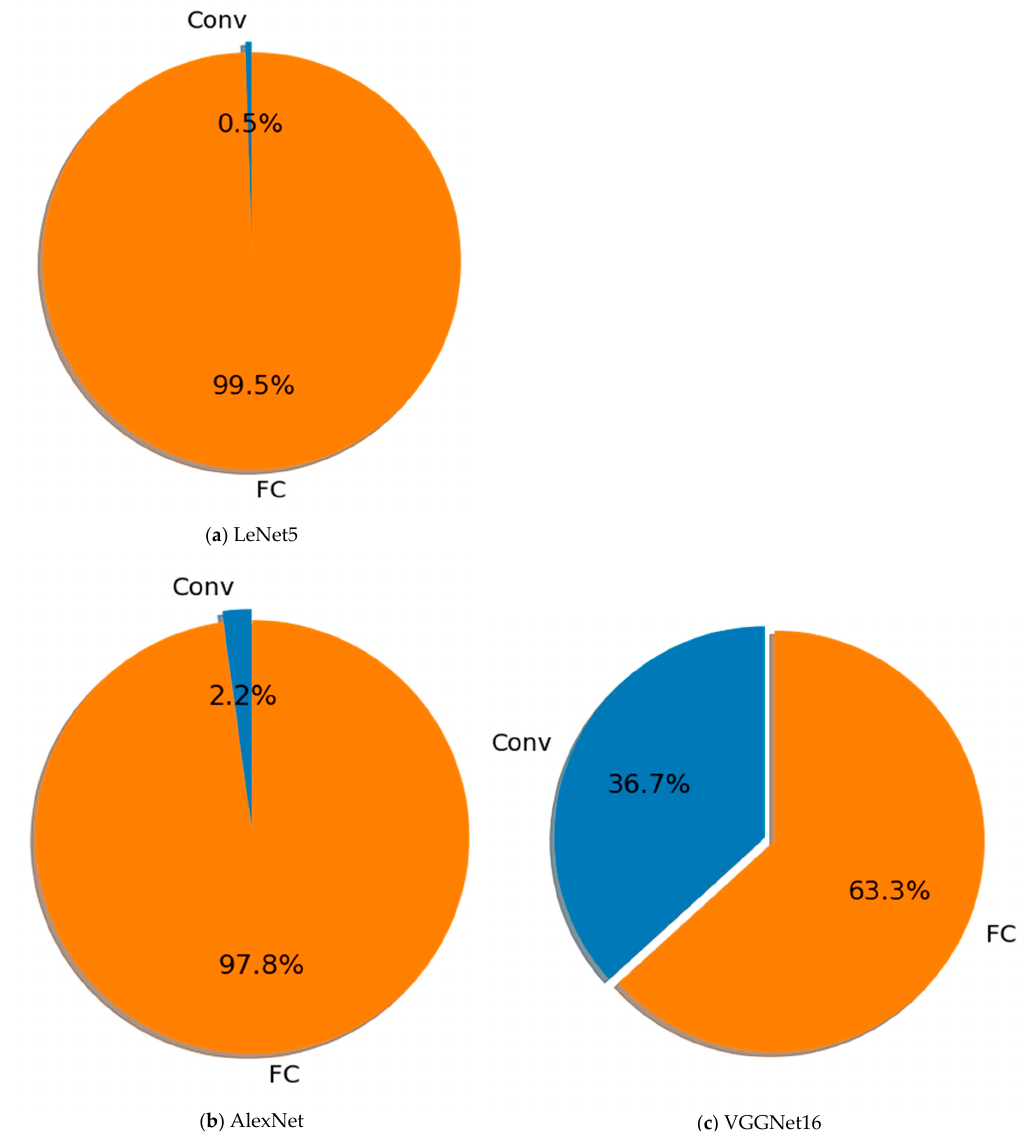
Figure 4. Weights sum for fully connected layers (orange) and convolutional layers (blue).